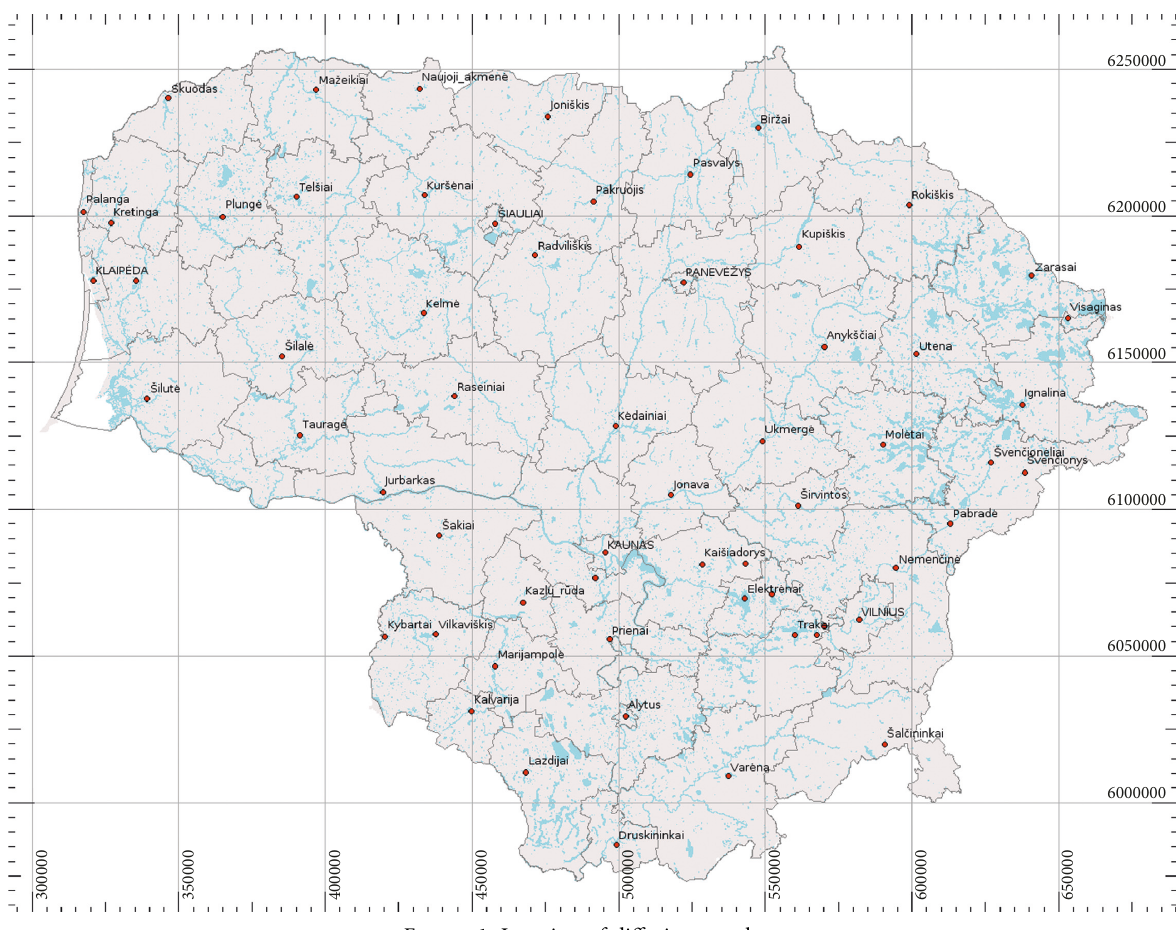
Figure 1: Location of diffusive samplers. Table 4: Uncertainty estimation according to